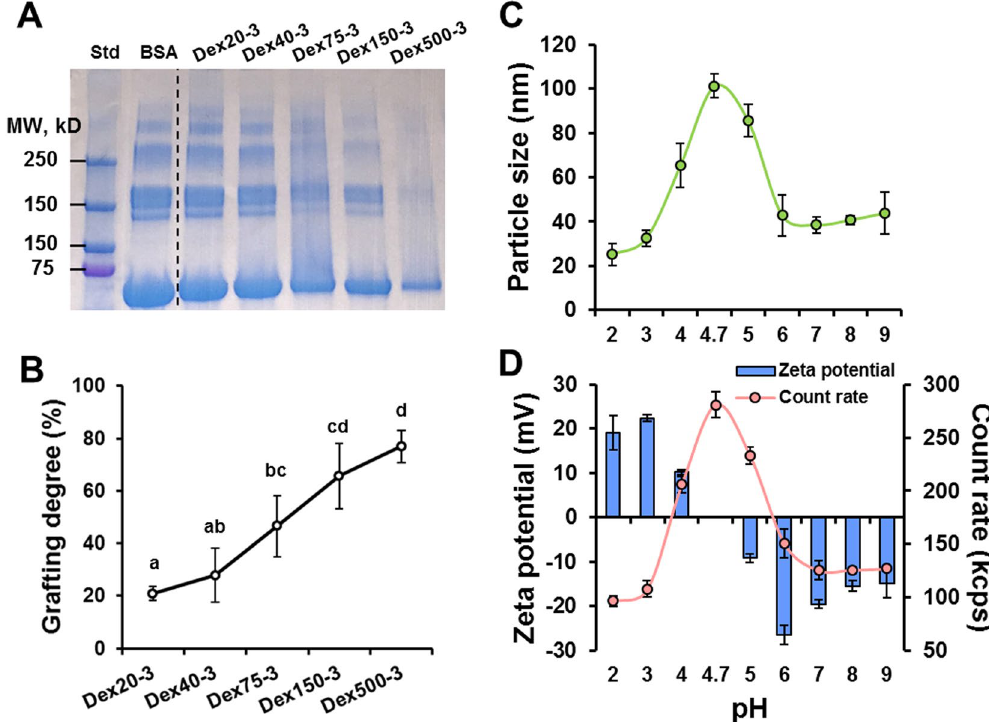
Figure 3. ( A ) SDS–PAGE analysis of BSA-Dextran conjugates produced by Maillard reaction with different experimental groups; ( B ) Grafting degree of Maillard conjugates; the pH dependence of particle size ( C ), and count rate and zeta potential ( D ) of Maillard conjugate (Dex75-3). In Fig. 3B, data not sharing the same letter were significantly different (p <